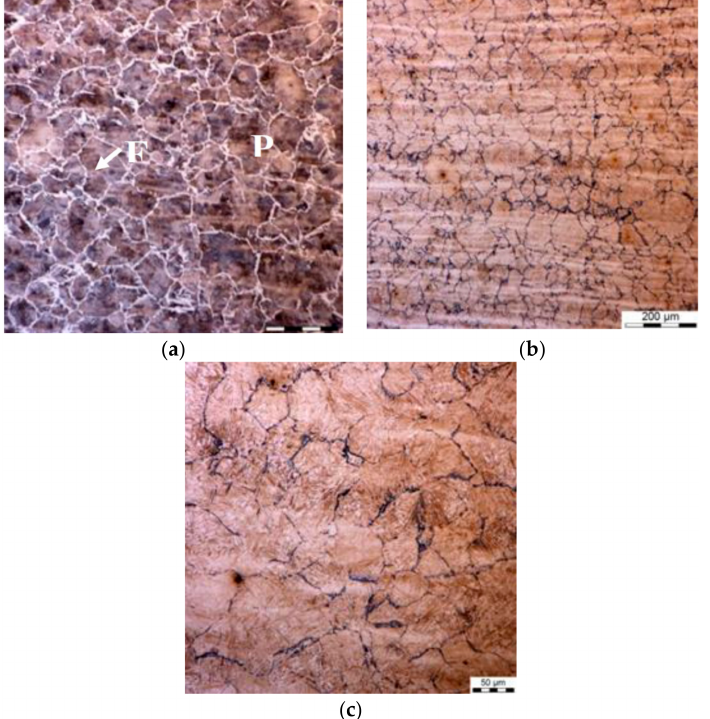
Figure 11. Point Q variant 1—microstructures of the samples after first cooling to 500 ◦ C ( a ), after heating to the holding temperature ( b ) and at the end of holding ( c